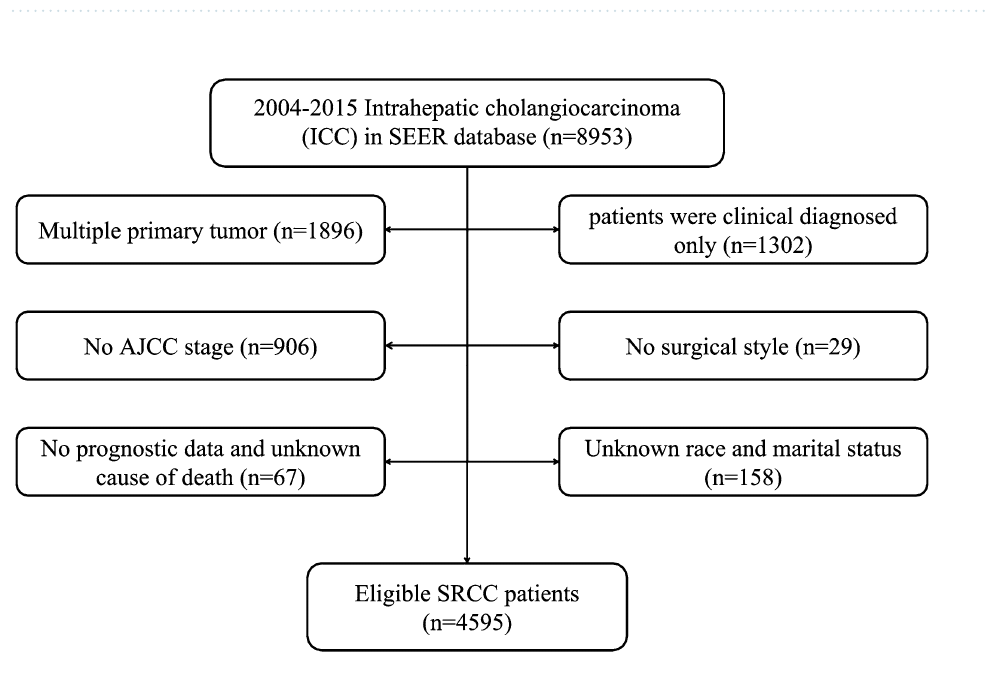
Figure 2. Flow chart for patient